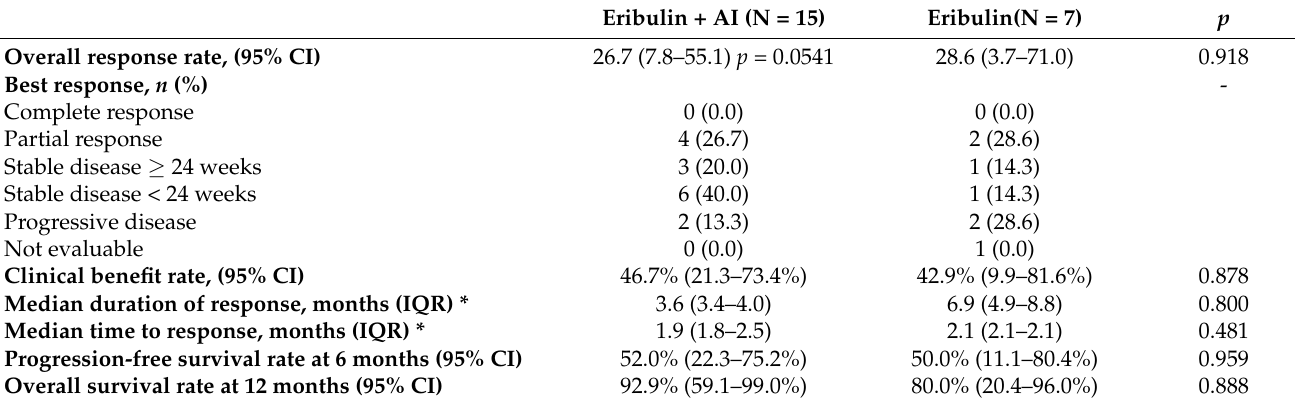
Table 2. Efficacy endpoint